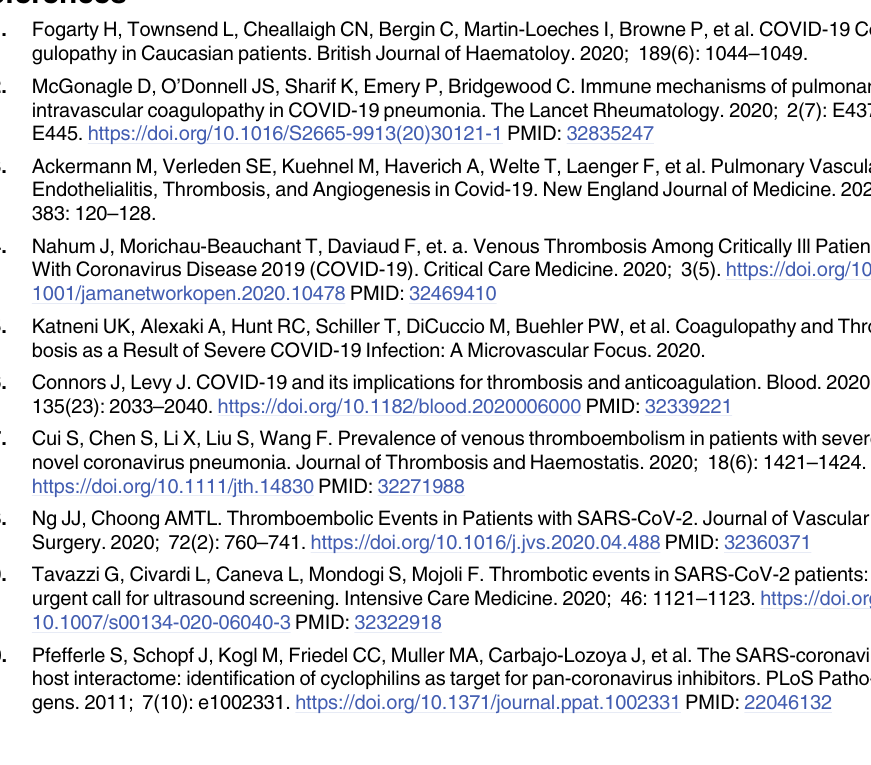
S5 Table. Computed features for all identified missense variants identified in proteins that interact with SARS proteins. S6 Table. Description, explanation and range of computed